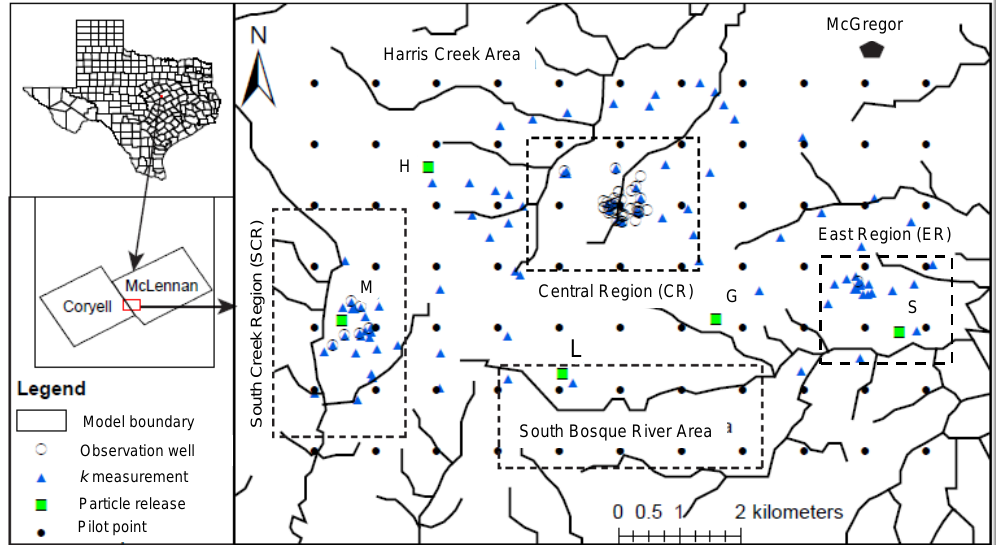
Figure 1. Study location showing streams, 43 observation wells (open circles), 99 hydraulic-conductivity measurement locations (blue triangles), 77 pilot points (filled circles), and particle-release locations (green squares) from NWIRP administrative designations G, H, L, M, and